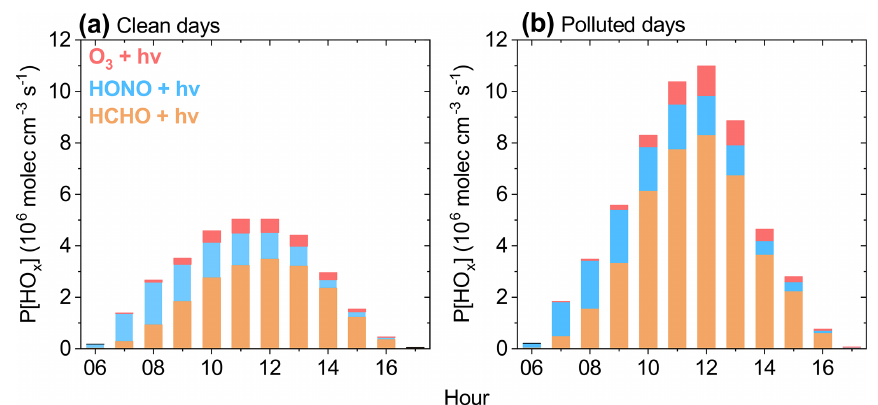
Figure 10. Diurnal variations in P [HO x ] through three pathways during the daytime of clean days ( a ; 13–19 and 21–24 October) and polluted days ( b ; 20, 25, and 26 October) at the SDZ